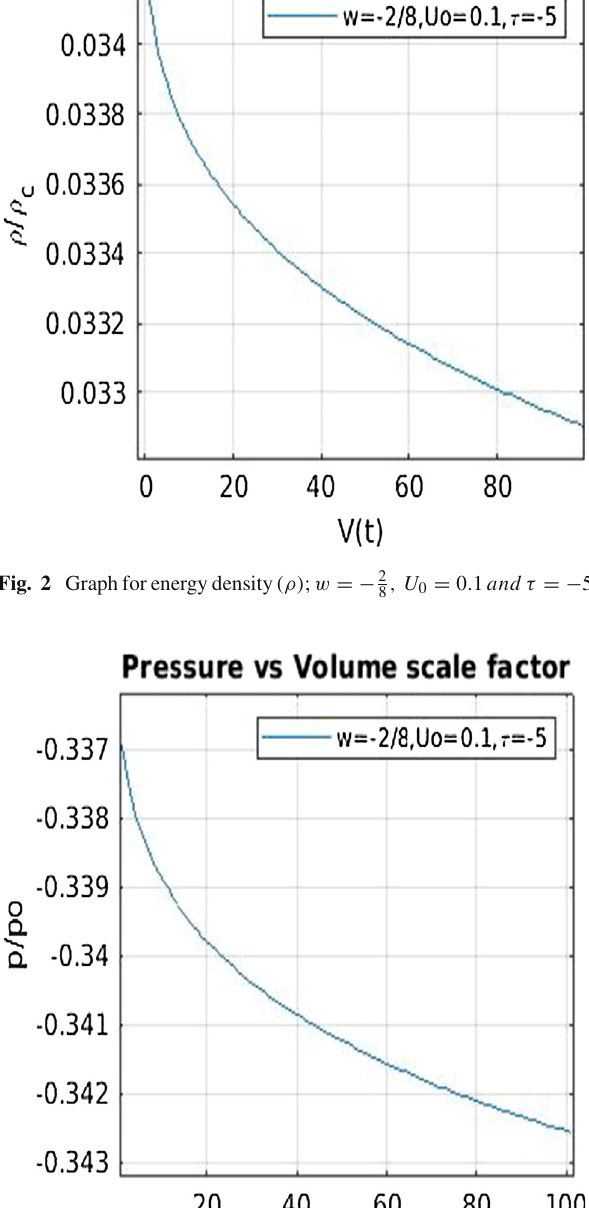
, U = 0 . 1 and τ = − 5 0 8